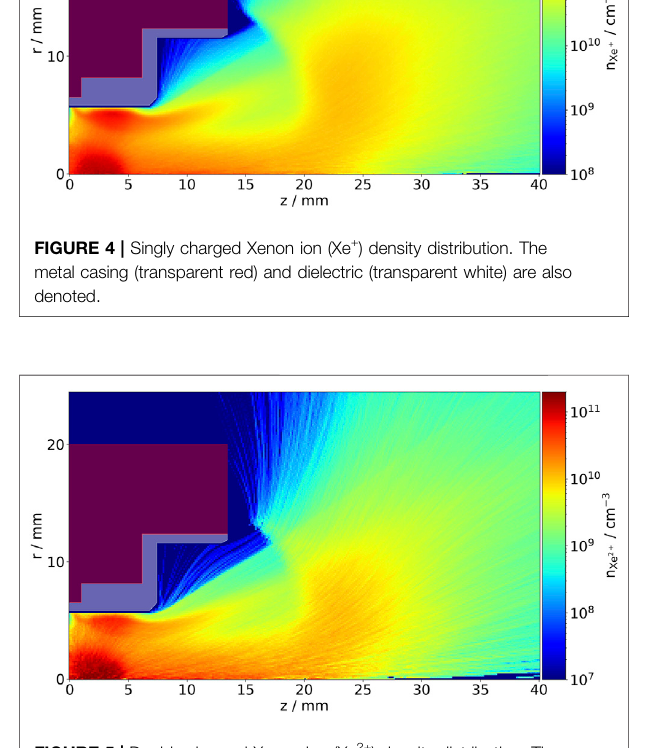
FIGURE 5 | Doubly charged Xenon ion (Xe 2+ ) density distribution. The metal casing (transparent red) and dielectric (transparent white) are also